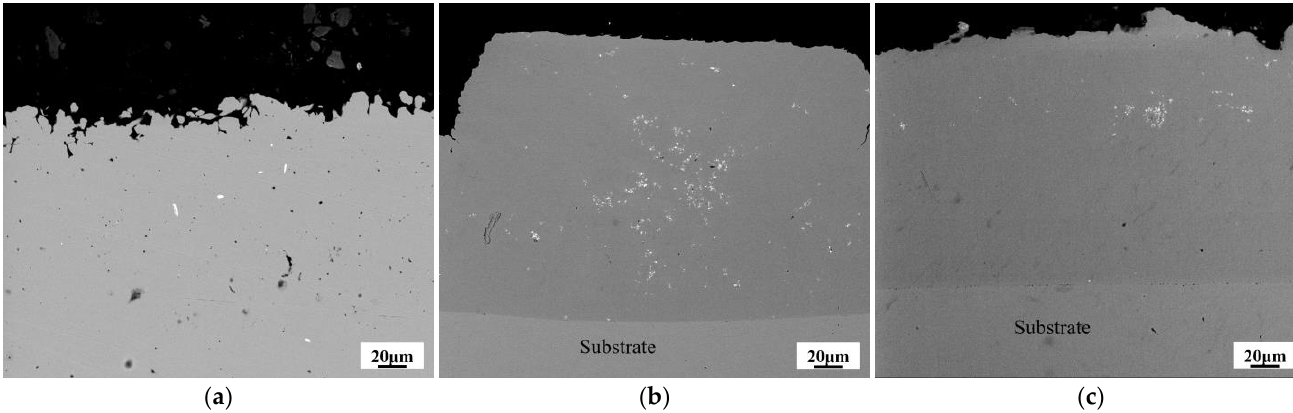
Figure 8. The cross-sectional SEM images of W – Cu composite coatings under different reverse duty cycles: ( a ) d r = 5%, ( b ) d r = 10%, and ( c ) d r = 15%, ( J = 2 A/dm 2 , f = 1500 Hz and d f = 40%).